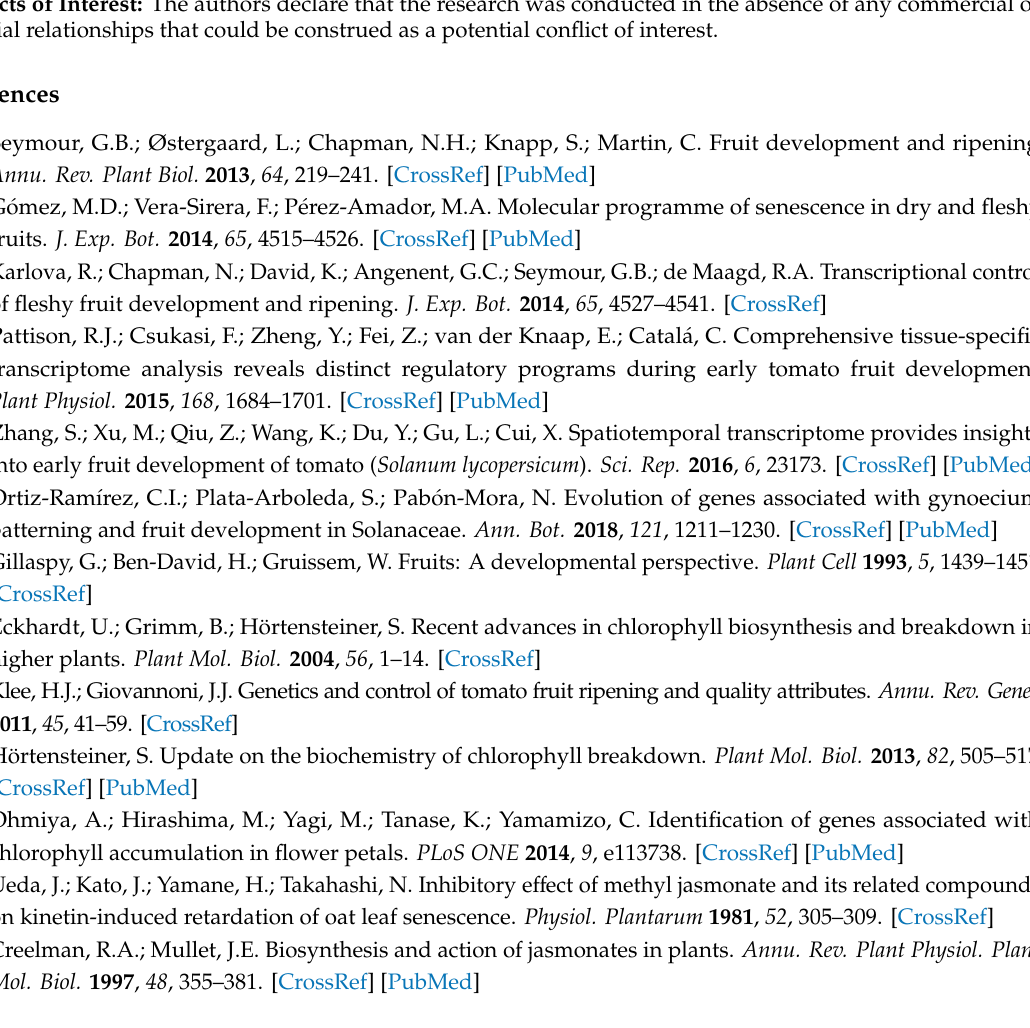
Figure S1: Hierarchical clustering of the common top-ranked 100 expressed genes, which was obtained from all replicates and samples in both PMB0225 and PHA1037 cultivars. Table S1: Quality and read mapping report. Table S2.1 and S2.1: FPKM values in up-regulated and down-regulated genes in stages ANT20, ANT30 and ANT45 (mature stages) in comparison to stages ANT5 and ANT10 (immature stages). Table S3.1 and S3.2: Enriched GO terms in up-regulated and down-regulated candidate maturation genes. Table S4.1 and S4.2: Up-regulated and down-regulated specific maturation genes grouped by KEGG pathways. Tables S5.1 and S5.2: Homologous up-regulated and down-regulated maturation genes shared by Arabidopsis thaliana and Phaseolus vulgaris . Table S6: KEGG pathway enrichment in fruit maturation genes shared by Arabidopsis thaliana and Phaseolus vulgaris . Table S7: Transcription factors whose TFBSs were significantly over-represented in the promoter regions of fruit maturation genes shared between common